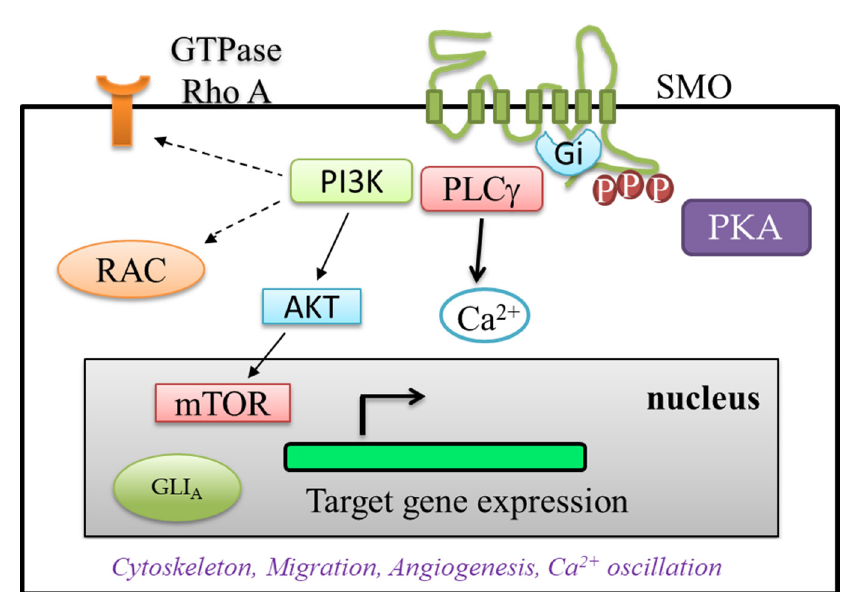
Figure 2. Noncanonical HH signaling pathway. SMO and GLI are activated through other signaling pathways such as PKA, GTPase, PI3K/mTOR or Rho to enable target gene expression. PKA phosphorylates the C-terminus of SMO at three sites. PI3K could activate the signaling through AKT, mTOR and turn on gene expression. PI3K could interact with RhoA and Rac, which could have effect on the cytoskeleton. PLC γ could act on Ca 2+ flux. Therefore, noncanonical HH signaling pathway can regulate cytoskeleton, cell migration, angiogenesis and Ca 2+ oscillation.